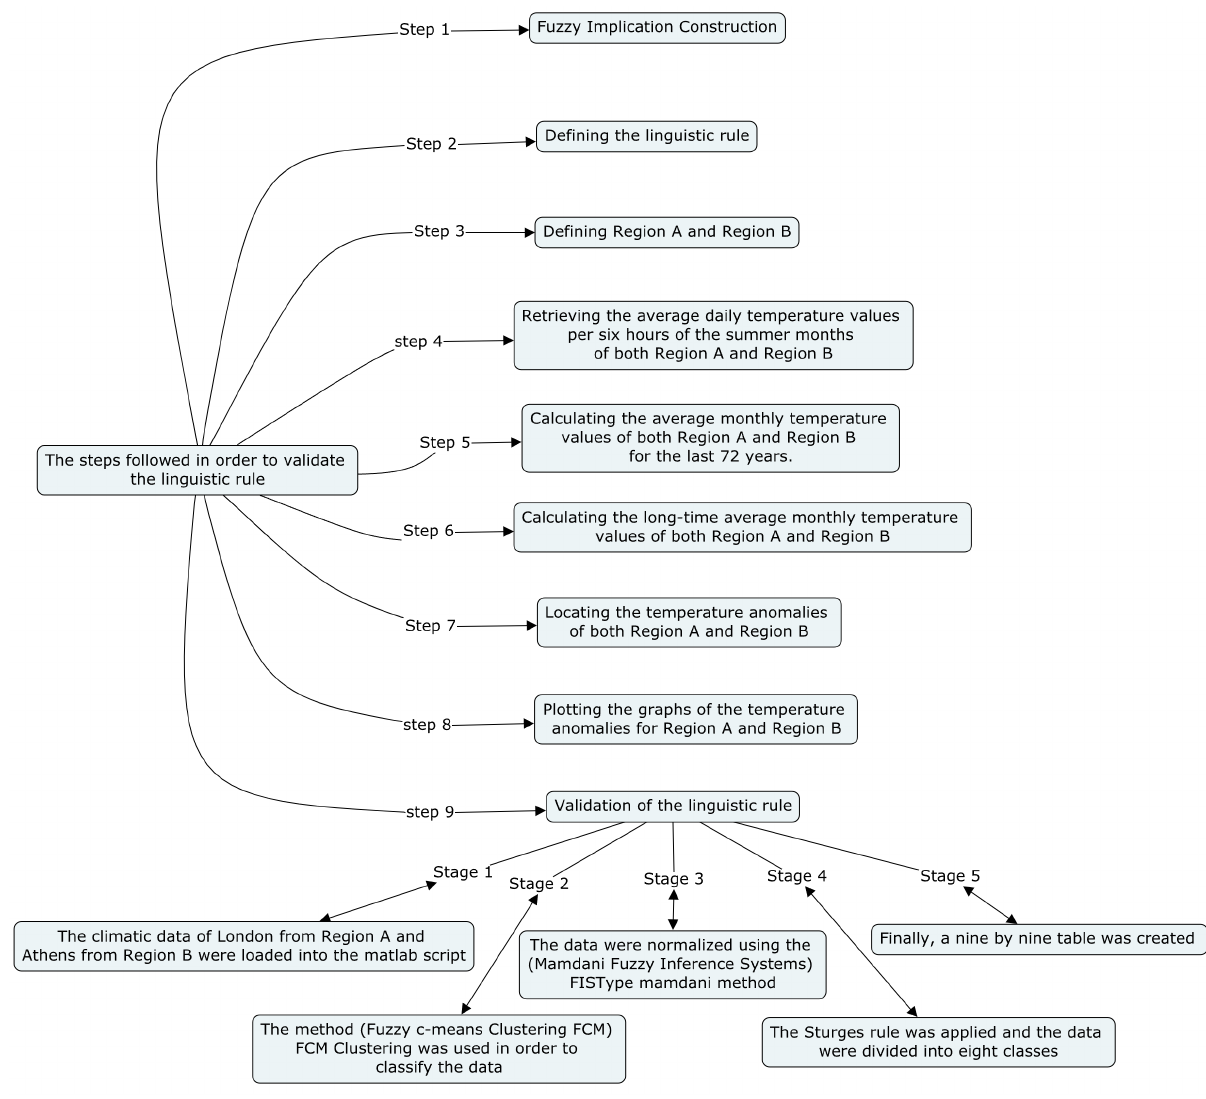
Figure 22. Validation of the linguistic